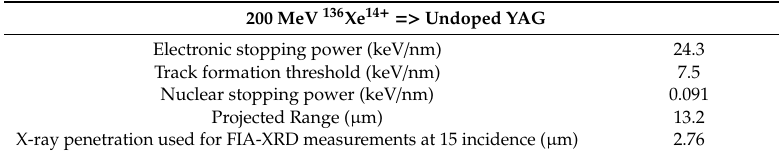
Table 1. Electronic and nuclear stopping powers (at the surface), and the projected range of 200 MeV 136 Xe 14 + . ions in yttrium-aluminum-garnet (YAG) crystal, calculated by SRIM 2013. The track formation threshold and the X-ray penetration depth of the Cr K α line used for fixed incident angle X-ray di ff ractometry (FIA-XRD) are also shown.